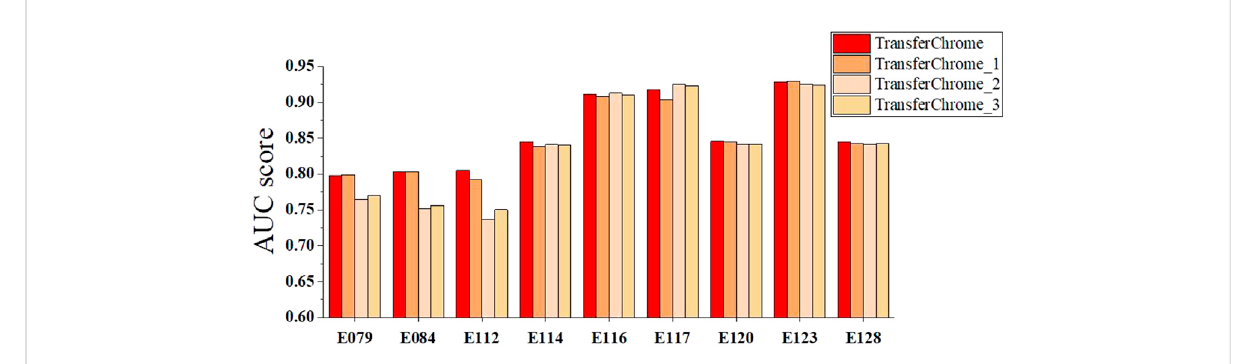
FIGURE 6 The performance comparison of different versions of TransferChrome: TransferChrome, TransferChrome_1, TransferChrome_2